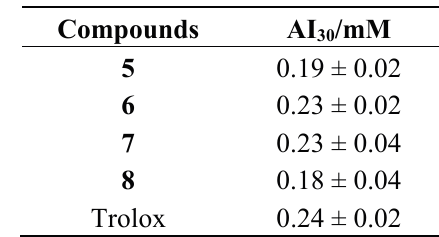
Figure 5. Cyclic voltammograms of superoxide radical at different concentrations of compound 6 in DMSO + TBAP 0.1 M, on GC (working electrode) versus Ag/AgCl, at room temperature, with scan rate of 30 mV/s. Table 4. AI 30 index calculated for compounds 5 – 8